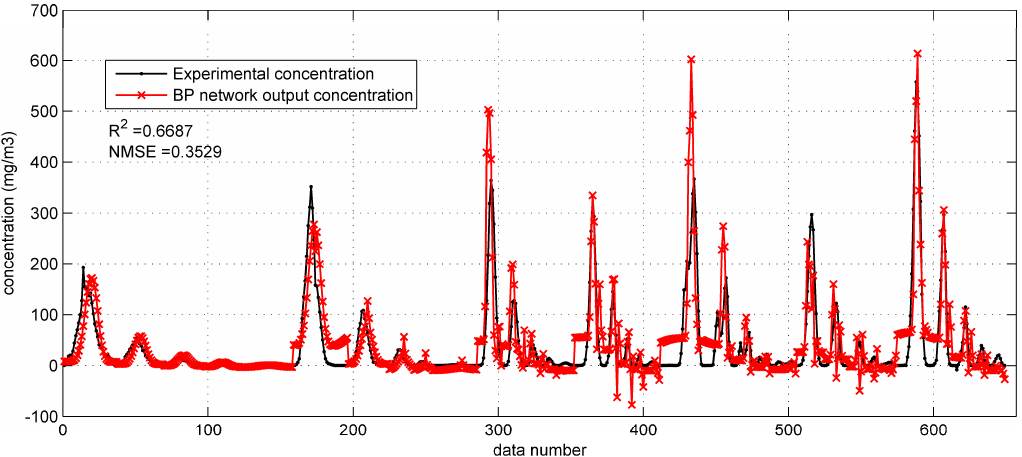
Figure 4. The prediction results of BP network with integrated Gaussian parameters on the test set in the Prairie Grass case.